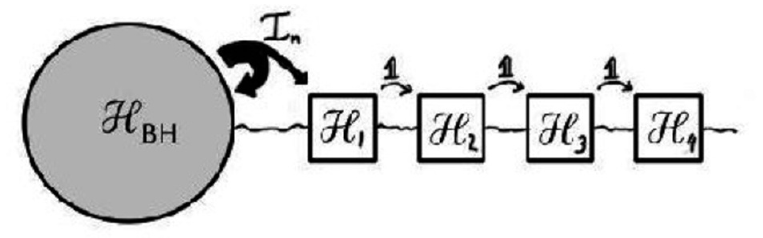
Figure 1 . Model for black hole evaporation. At each step, the state of the black hole is mapped via an isometry to a state of the combined system of the black hole plus the (cid:12)rst radiation subsystem, while the state of the n th radiation subsystem is transferred to the state of the ( n + 1)st radiation